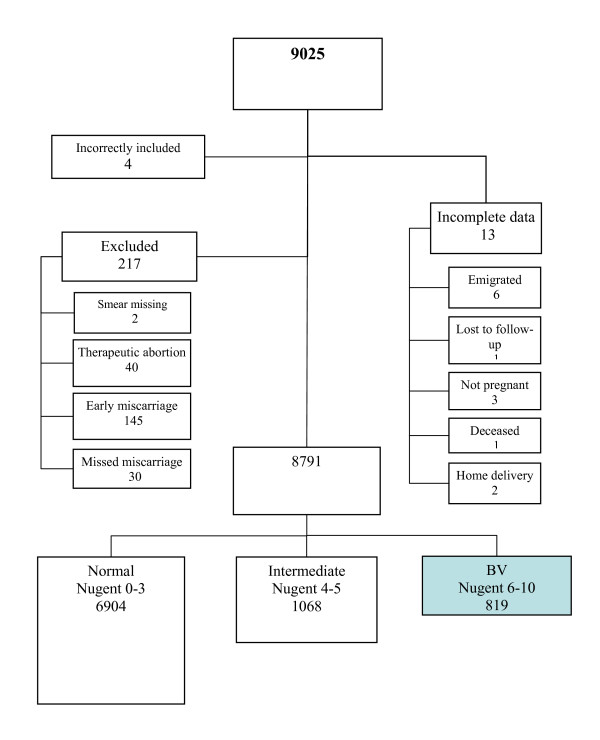
Flow chart of the participation status in the preterm delivery study. At start there were 9025 women and 8791 remained throughout the study.